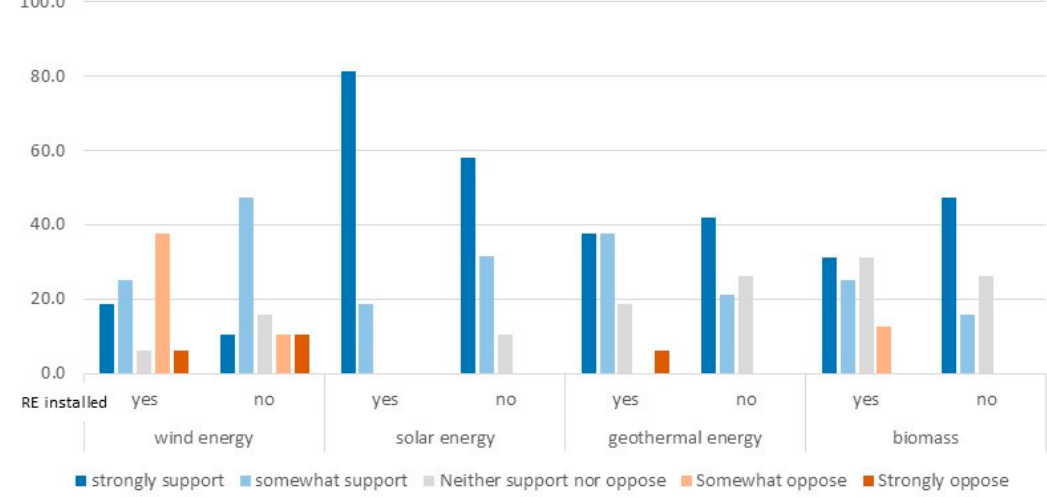
Figure 5. Participants’ preference for types of renewable energy.